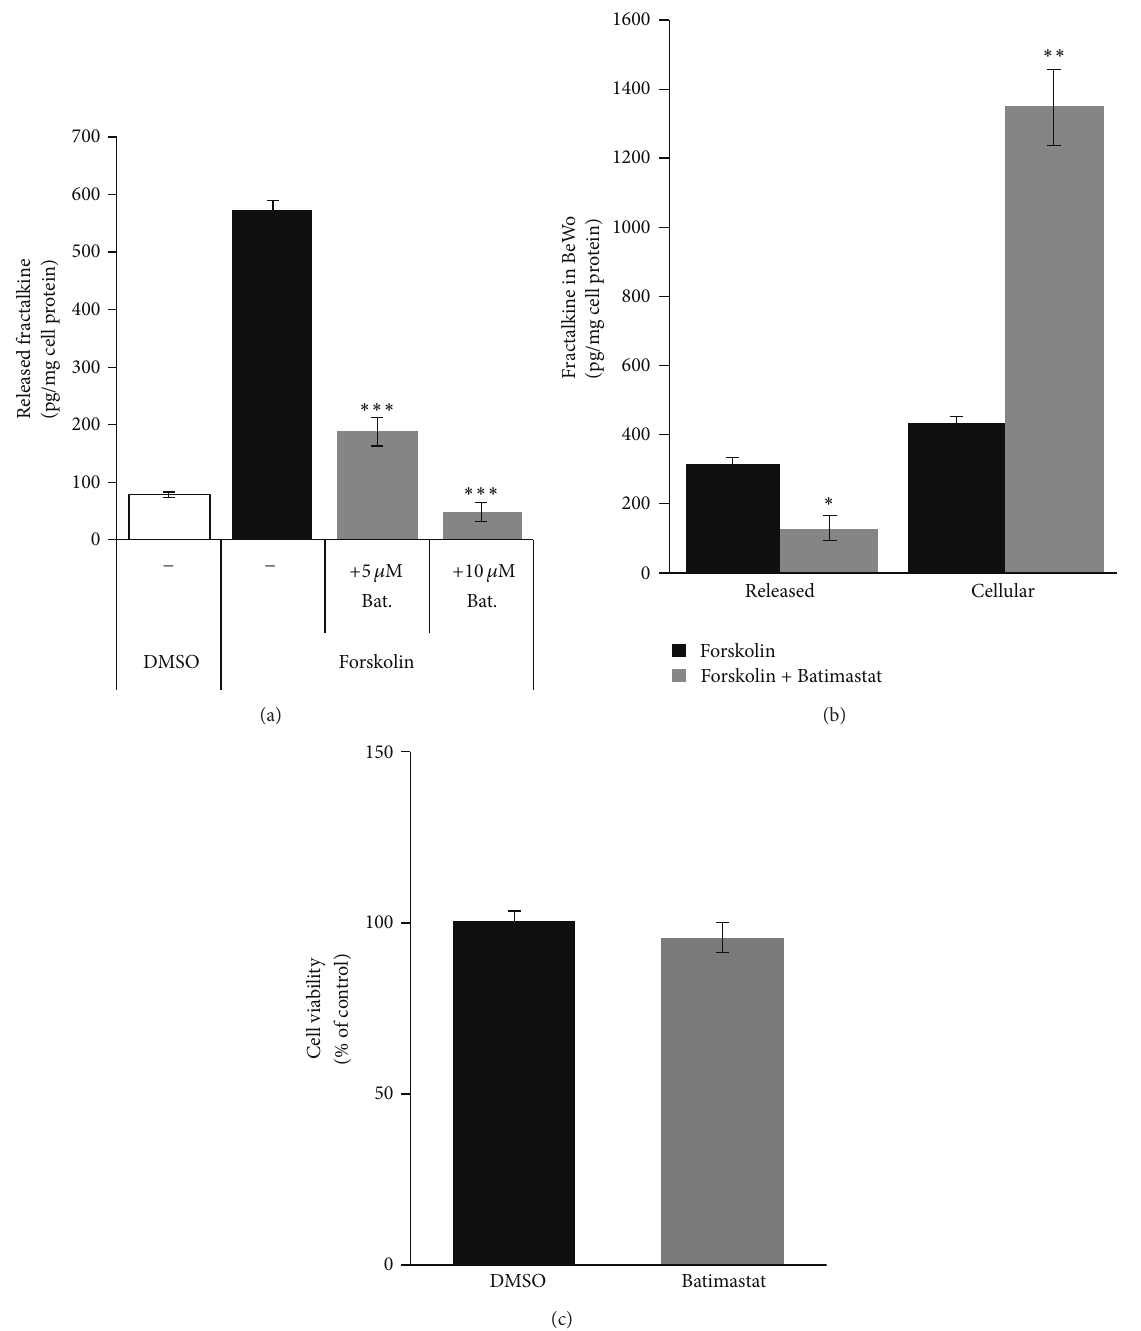
Figure 4: Effect of Batimastat on the release of soluble fractalkine in the trophoblast cell line BeWo. Increasing concentrations of the metalloprotease inhibitor Batimastat (5 𝜇 M and 10 𝜇 M, resp.) inhibited forskolin (20 𝜇 M) induced upregulation of fractalkine release in BeWo cells after 48 h (a). Inhibition of fractalkine release by Batimastat (10 𝜇 M) was accompanied with an increase in cell bound fractalkine in BeWo cells after 48h (b). Batimastat (10 𝜇 M) slightly but not significantly decreased viability of BeWo cells compared to control ( 𝑃 = 0.456 ) (c). Data are presented as mean ± SEM from three independent experiments performed in triplicate. ∗ 𝑃 ≤ 0.05 , ∗∗ 𝑃 ≤ 0.01 , ∗∗∗ 𝑃 ≤ 0.001 .